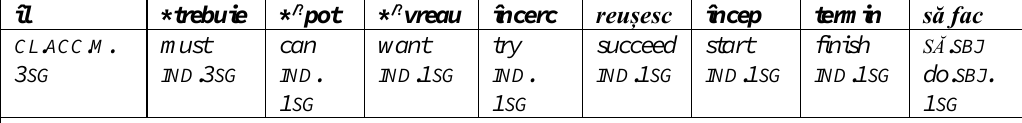
Table 8. Clitic-climbing in Moldovan complex predicates containing subjunctives îl * trebuie * /? pot * /? vreau încerc reușesc încep termin să fac CL . ACC . M . 3 SG